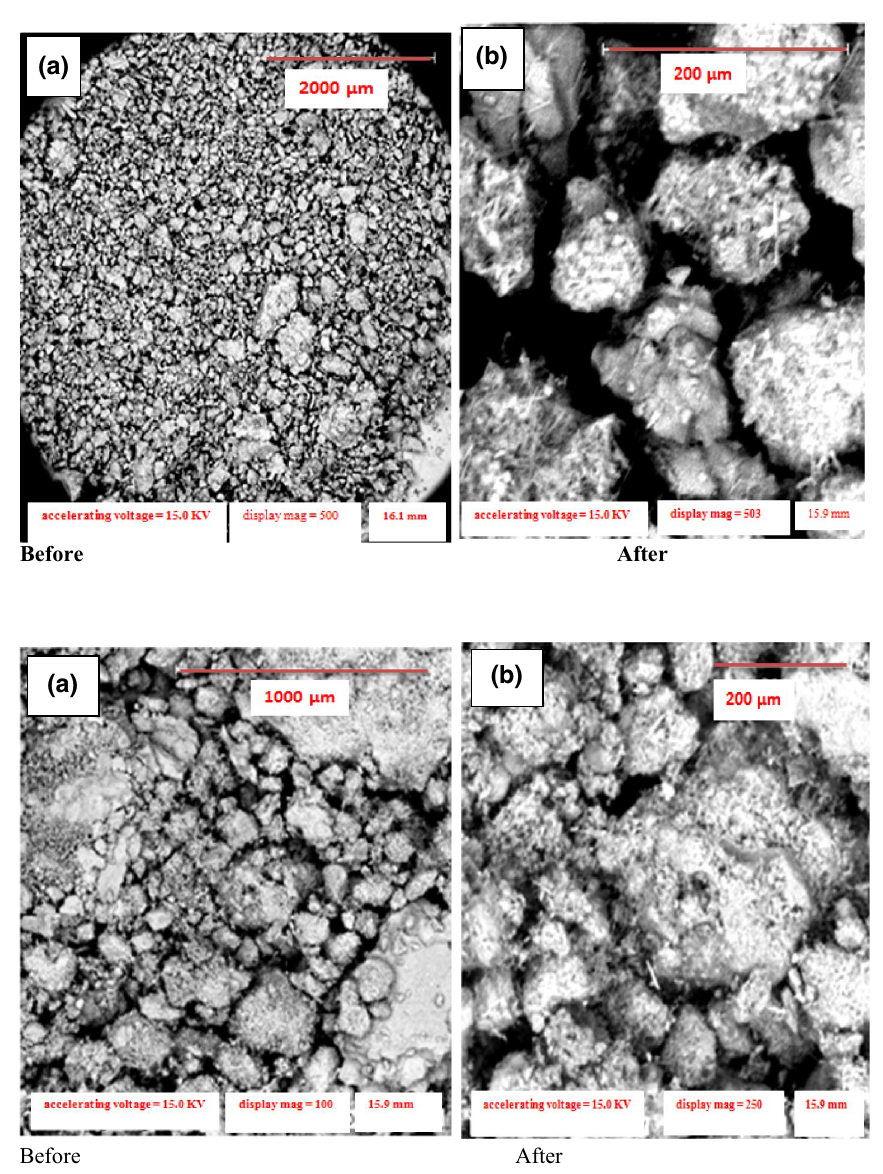
Fig. 9 SEM micrograph of MSA before and after adsorp- tion